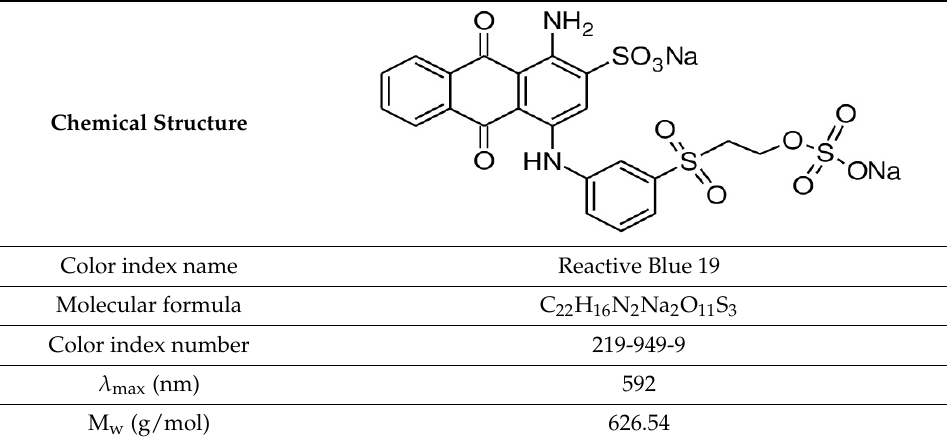
Table 1. The characteristics of C.I. reactive blue 19.